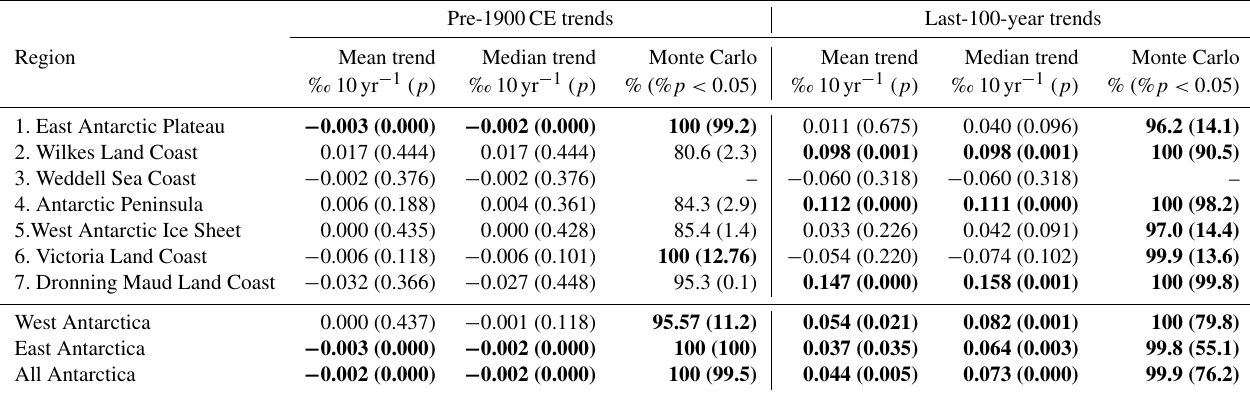
Table 2. Summary of trend statistics for isotopic anomalies using unweighted composites. Trends are expressed as isotopic anomalies, in per mille δ 18 O per decade units. Trends and their significance ( p ; based on the Student’s t statistic) are calculated using a linear additive model and reported for the mean and median composites. Monte Carlo testing is applied to 10000 ensemble members based on the unweighted composite distributions, which are assessed to determine the percentage of trends with the same sign as the mean trend and the percentage with the same sign and a significance of p < 0 . 05. Bold values indicate mean and median trends with a significance of p < 0 . 05 and Monte Carlo simulations where significant; same-signed trends exceed 5% of the